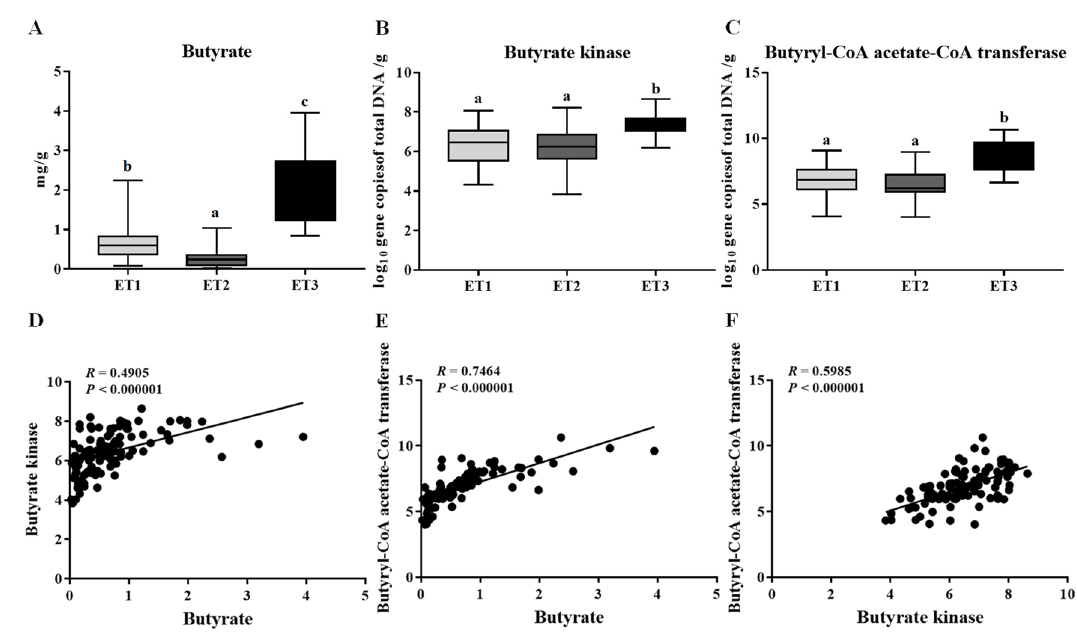
Figure 5. Butyrate contents ( A ) and the gene copies of butyrate kinase ( B ) and butyryl CoA: acetate CoA transferase ( C ) in the fecal samples of three ETs and their correlations as evaluated by Spearman’s rank correlation coefficients ( D – F ). The butyrate contents were expressed as mg/g of fresh feces. The abundance of functional genes was expressed as log10 gene copies of total DNA/g of fresh feces. Different letters indicate a significant difference ( p < 0.05) with the 95% confidence interval. Abbreviation: ET, enterotype.